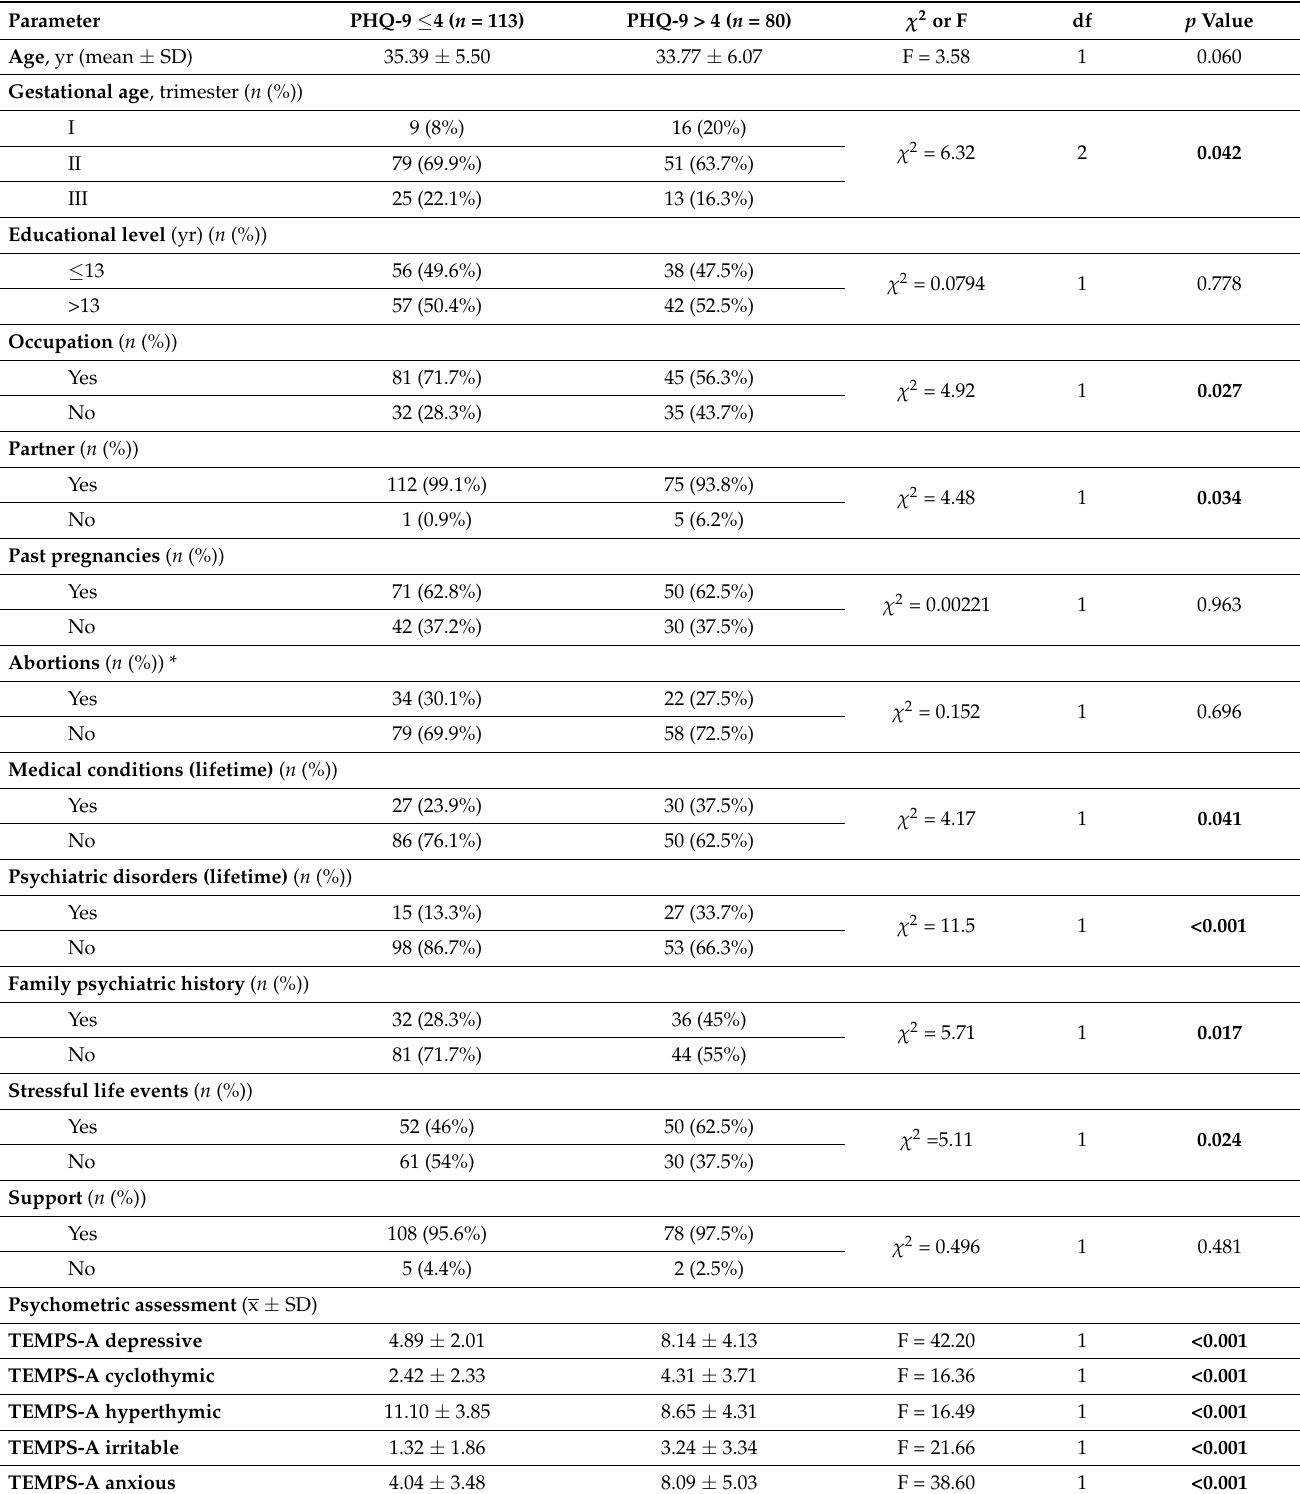
Table 1. Sociodemographic variables, epidemiologic characteristics, and temperament scores in the entire sample ( n =